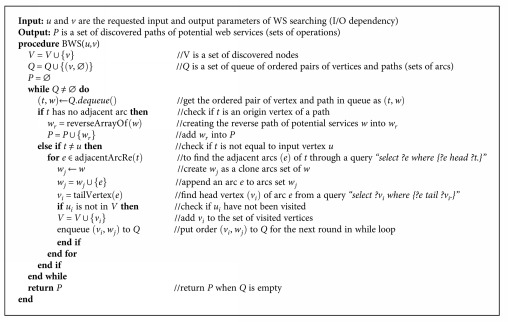
Backward search.